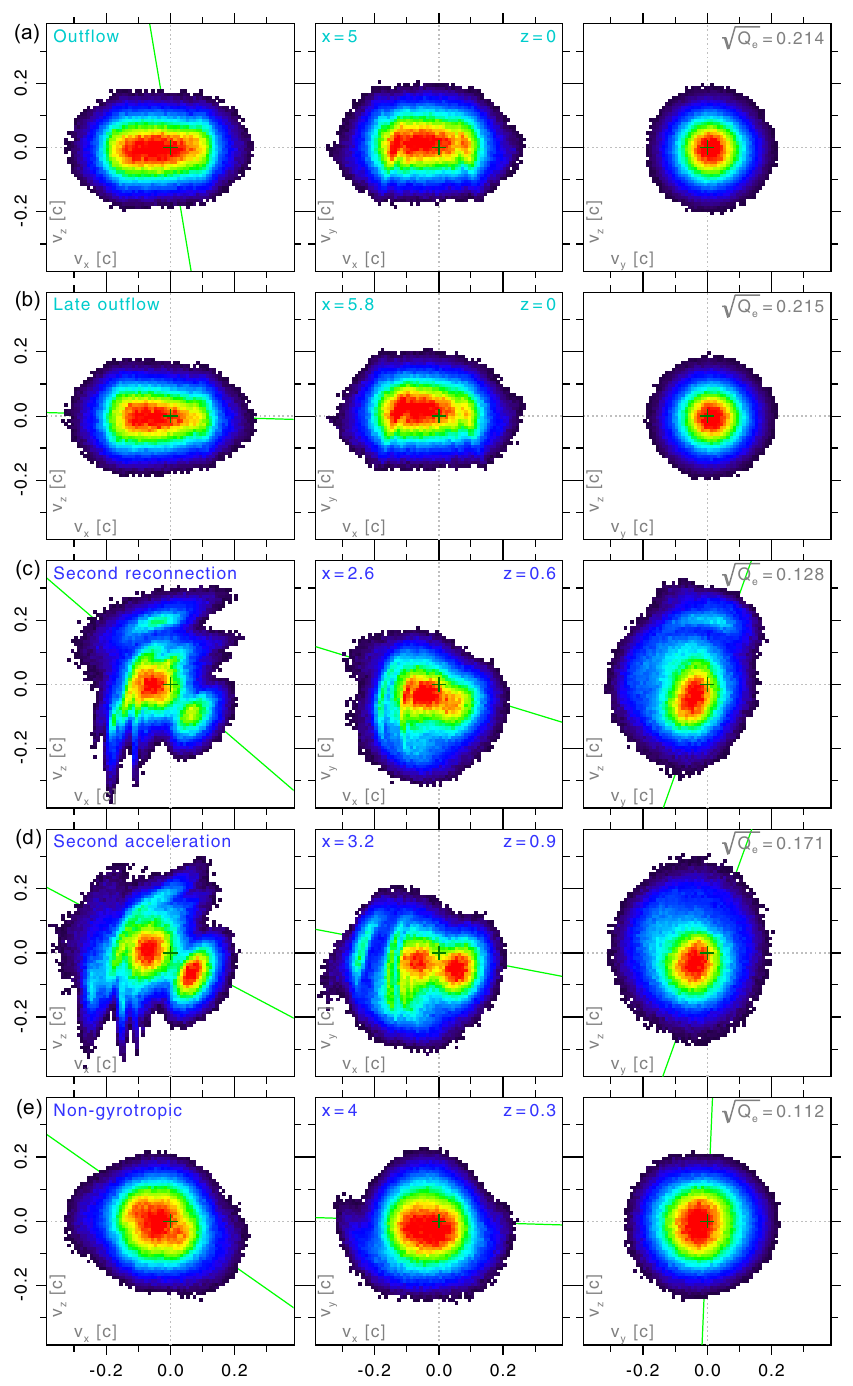
Figure 9. Same as Fig. 5 but showing the outflow and regions with an enhanced non-gyrotropy index Q e